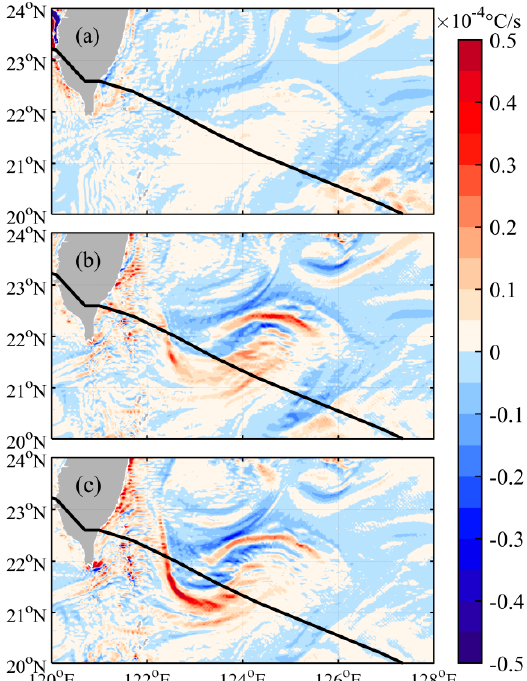
Figure 12. The distribution of surface BSMT in the dashed black box of Figure 5b. The black line indicates the TC track. ( a ) 9 July 2016; ( b ) 10 July 2016; ( c ) 11 July